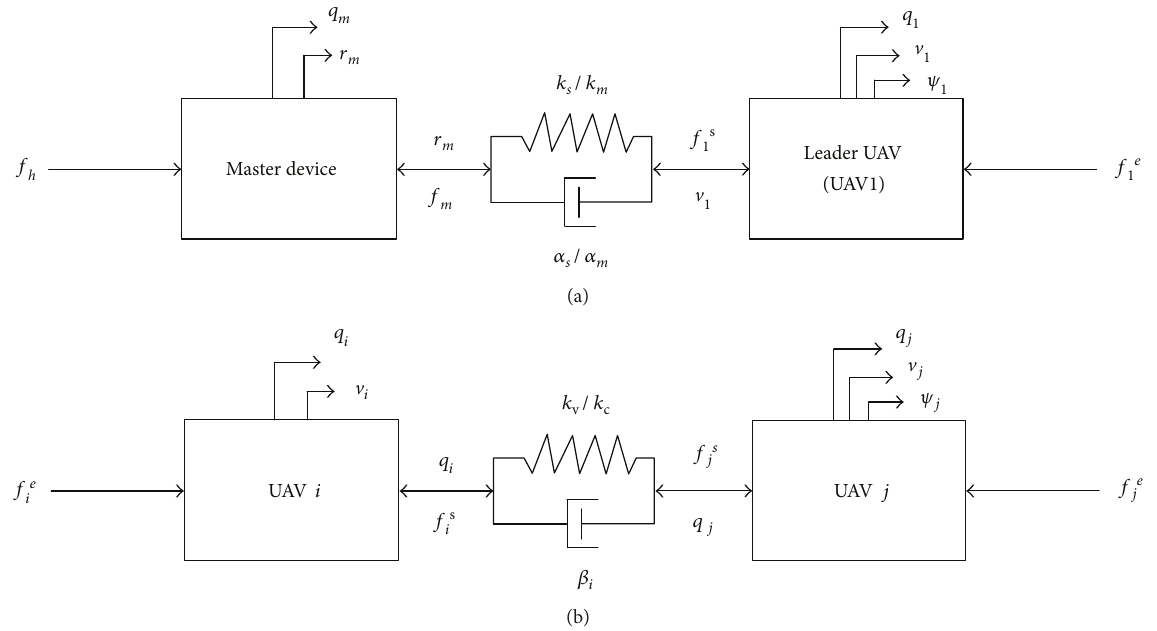
Figure 4: The distributions of local damping in the aerial teleoperation system. (a) The distribution of the damping between the master and the leader UAV. (b) The distribution of the damping among the slave